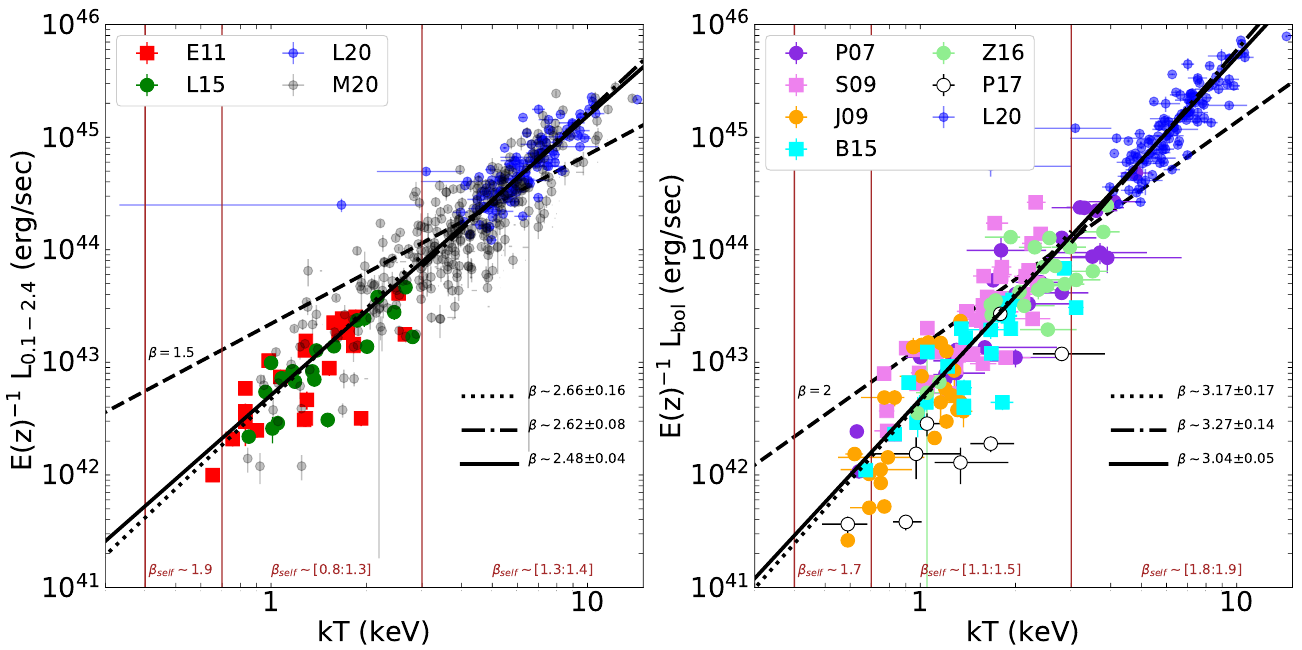
Figure 3. XMM–Newton (circles) and Chandra (squares) measurements of the L 0.1 − 2.4 –T x ( left panel ) and L x,bol –T x ( right panel ) relations for different samples of groups: (Eckmiller et al. [96], E11), (Lovisari et al. [77], L15), (Sun et al. [81], S09), (Johnson et al. [90], J09), (Bharadwaj et al. [32], B15), (Zou et al. [79], Z16), (Pearson et al. [109], P17). The groups measurements are compared with the ones from X-ray-selected (Migkas et al. [110], M20) and SZ-selected (Lovisari et al. [34], L20) cluster samples. We note that different studies used different atomic models (including APEC v1.3.1 which provide a significantly different modeling of the Fe-L line with respect to newer versions). The luminosities are all within R 500 while temperatures are obtained in different regions (see Table 2). The Chandra measurements are converted to XMM–Newton -like temperatures using the relations given in Schellenberger et al. [111]. Empty symbols are from optically selected samples. The lines represent the fitted relation for T x < 3 keV systems (dotted), T x > 3 keV systems (dashed-dotted), all systems (solid), and are compared with the case predicted by the self-similar scenario (dashed). The fits have been performed with LIRA (Sereno [112]) assuming self-similar time evolution and, conservatively, without the scatter on the X variable, and are meant for visualization purposes only. In brown we provide the expected values for the slope using the dependence of the emissivity tabulated in Table 1 for different ranges of temperatures (showed as brown vertical